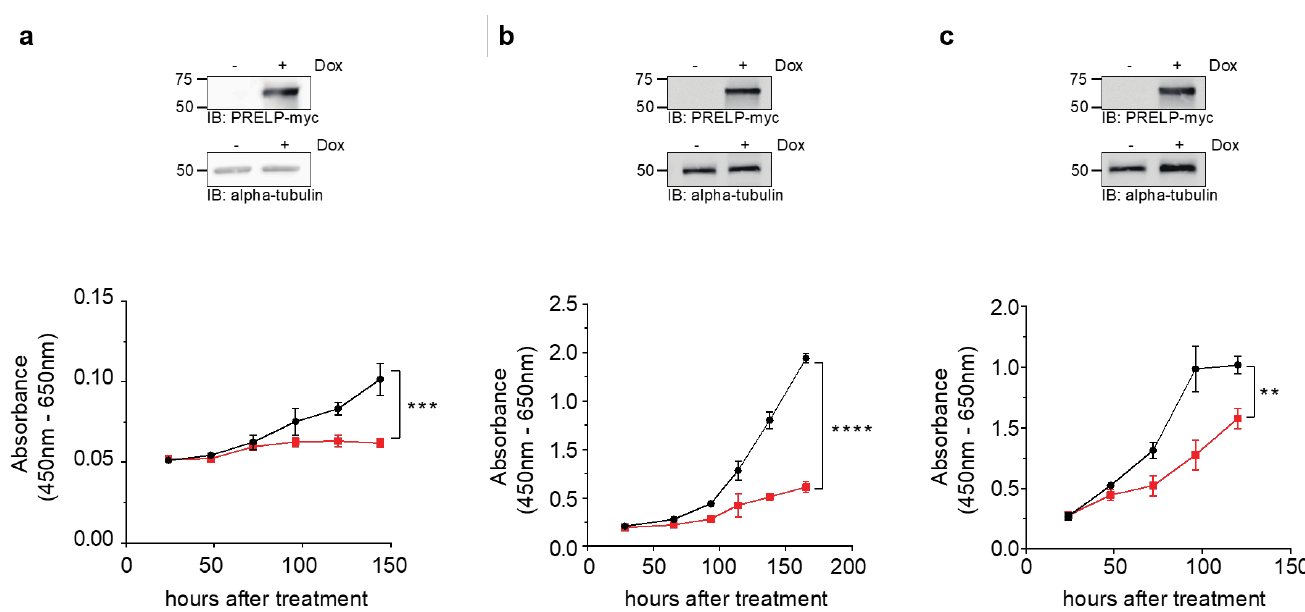
Figure 3. Reduced cell viability associated with induced PRELP gene expression in ovarian clear cell carcinoma (OCCC) cell lines. PRELP gene expression was induced by adding doxycycline (DOX) (1 µ g/mL) to the lenti-viral expression system. The expression of myc-tagged PRELP protein was analyzed using whole-cell extracts from ( a ) RMG-I, ( b ) OVTOKO, and ( c ) SKOV3 cells with or without DOX. The left side indicates the protein size marker. Alpha-tubulin; loading control. The cell viability of ( a ) RMG-I, ( b ) OVTOKO, and ( c ) SKOV3 cells was evaluated using Cell-Counting Kit-8 assays. Black lines; without DOX, red lines; with DOX. Error bars indicate biological replicates ( n = 3 or 4). Statistical analysis was performed using Student’s t -test. ** p < 0.01; *** p < 0.001; **** p < 0.0001.